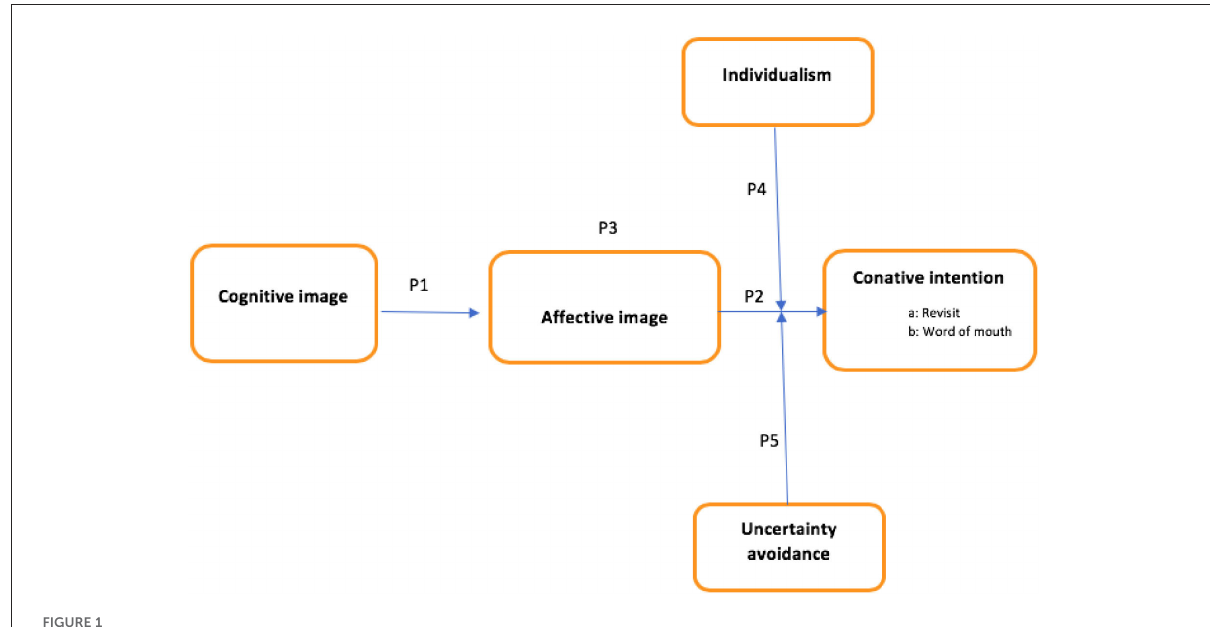
FIGURE1 Theoretical